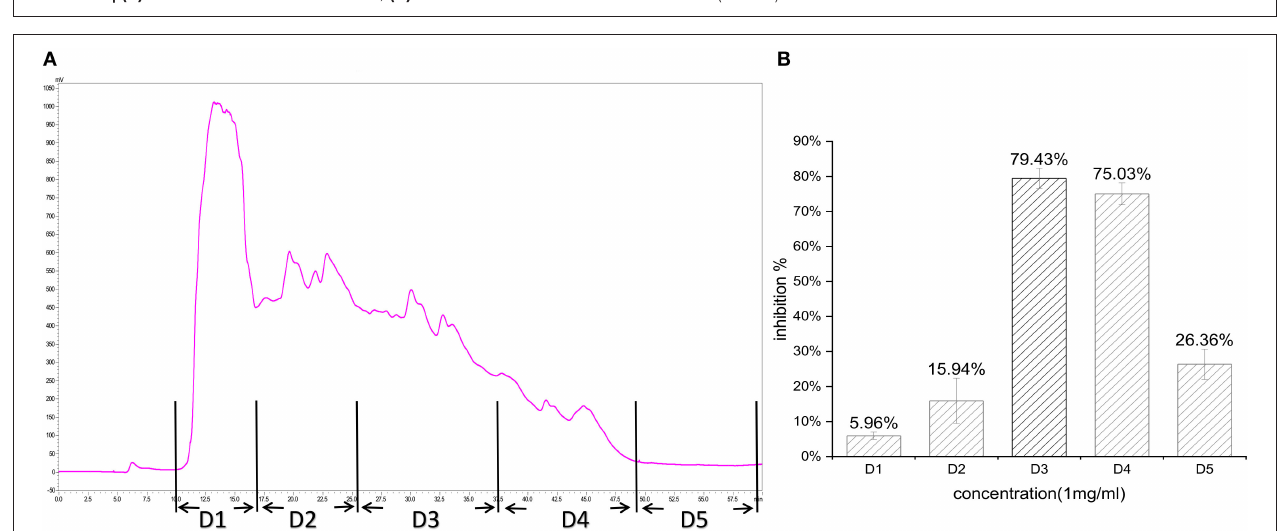
FIGURE 1 | (A) Molecular distribution of RWLE; (B) inhibition of different molecular fractions (G1–G4).